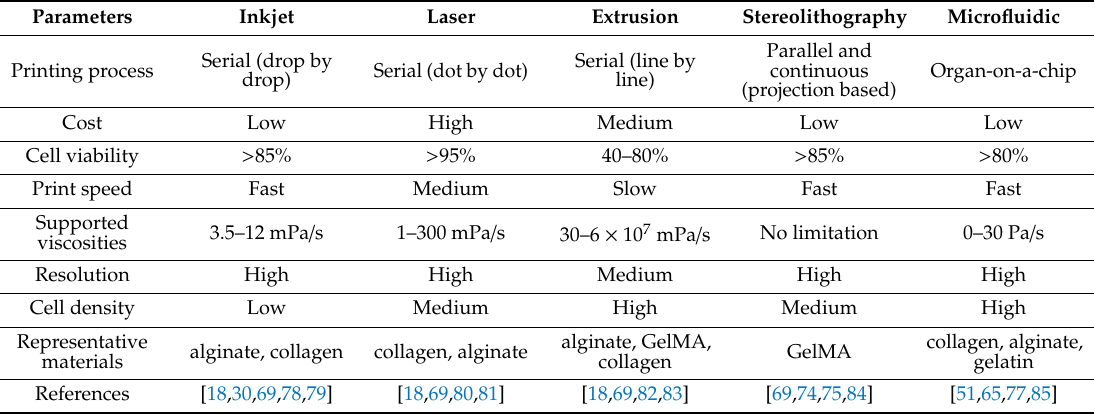
Table 1. Comparison of five types of bioprinting